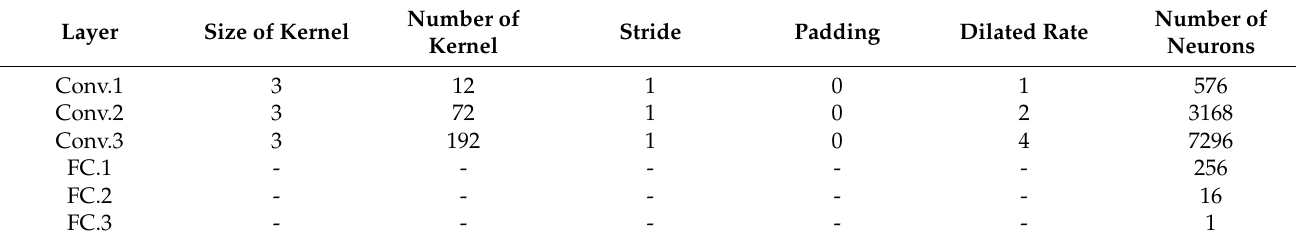
Table 2. Configuration of Dilated